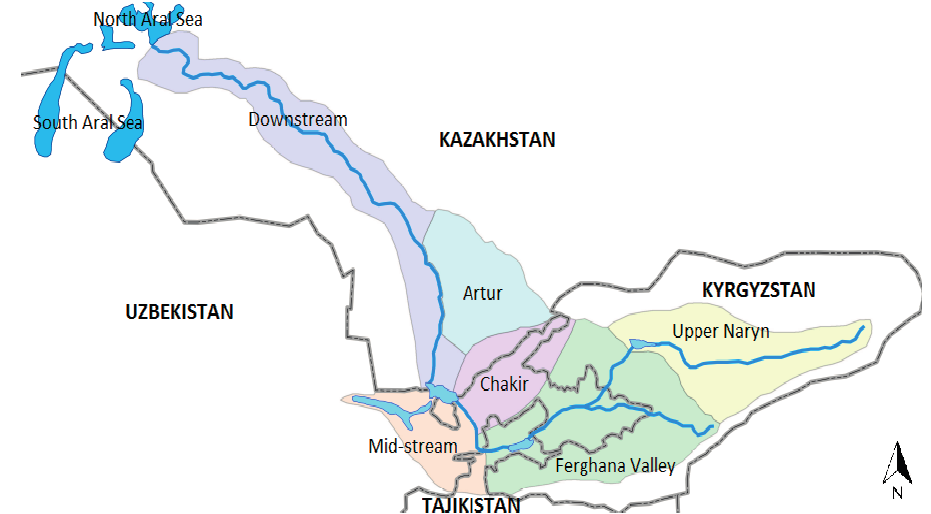
Figure 2. Irrigation districts in the Syr Darya